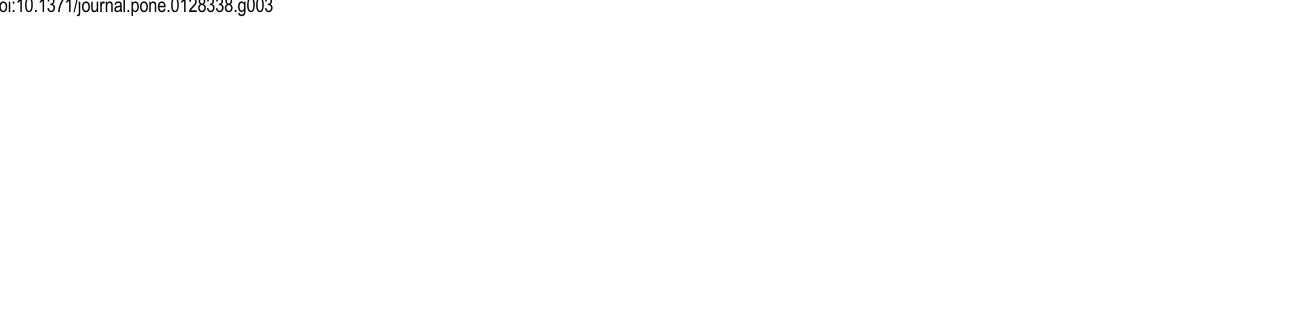
PLOS ONE | DOI:10.1371/journal.pone.0128338 June 17,